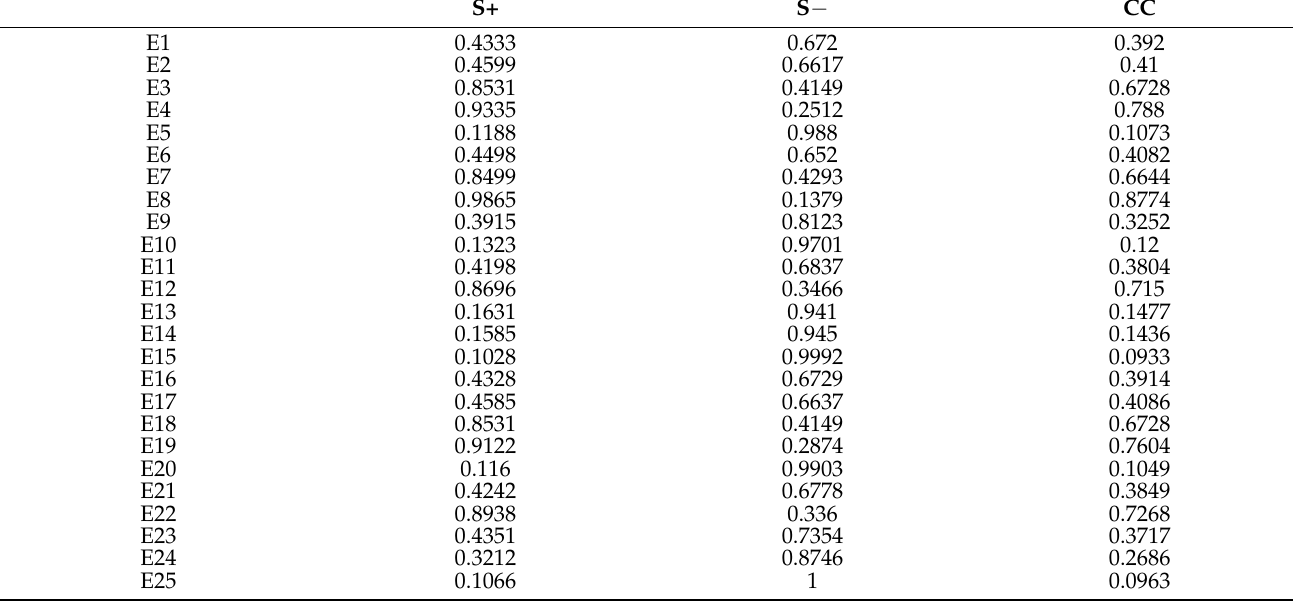
Table A2. The values of S+, S − , and CC